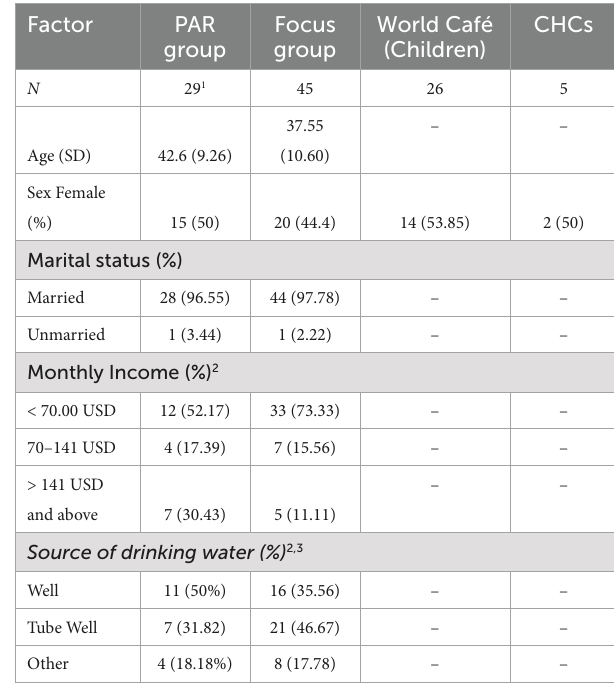
TABLE 1 Sociodemographic characteristics of the